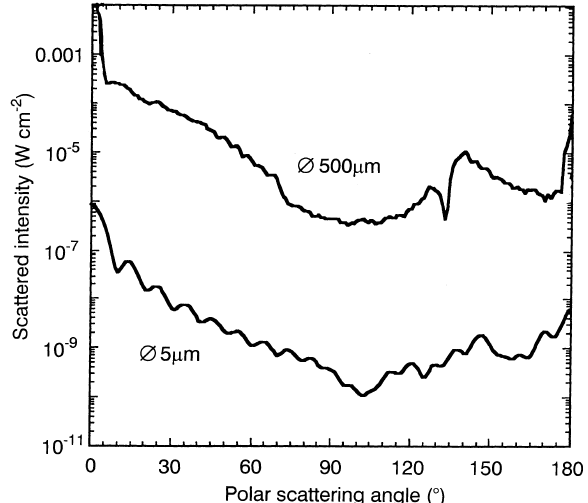
Fig. 2. Theoretical scattering phase functions (expressed in W cm ) 2 ) for single droplet (5 and 500 (cid:108) m diameter, respectively) present in the sampling volume of the Polar